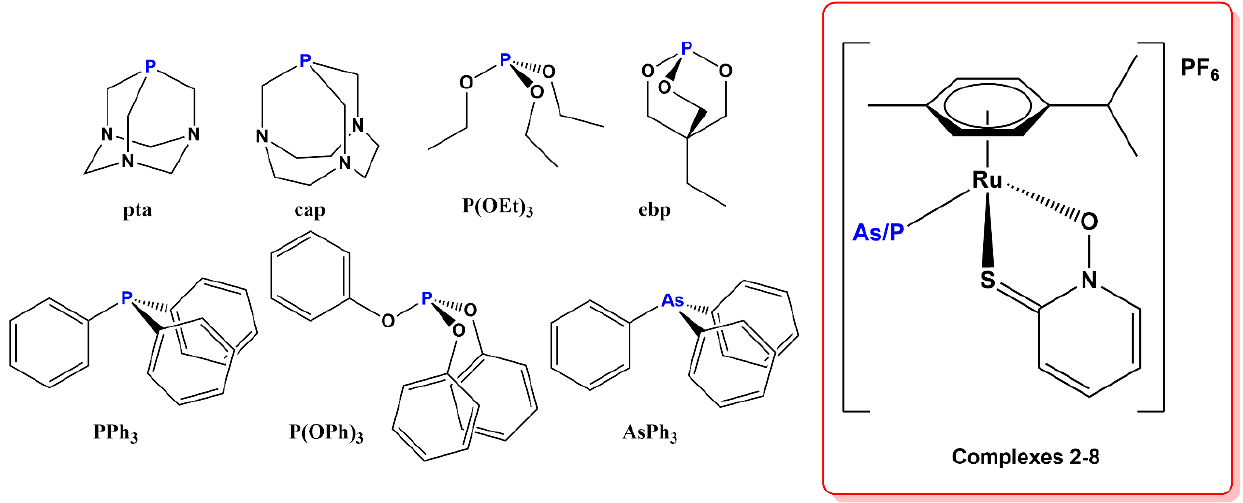
Figure 2. Phosphine, phosphite, and triphenyarsine ligands used in this study and the general structure of synthesized complexes 2 – 8 .